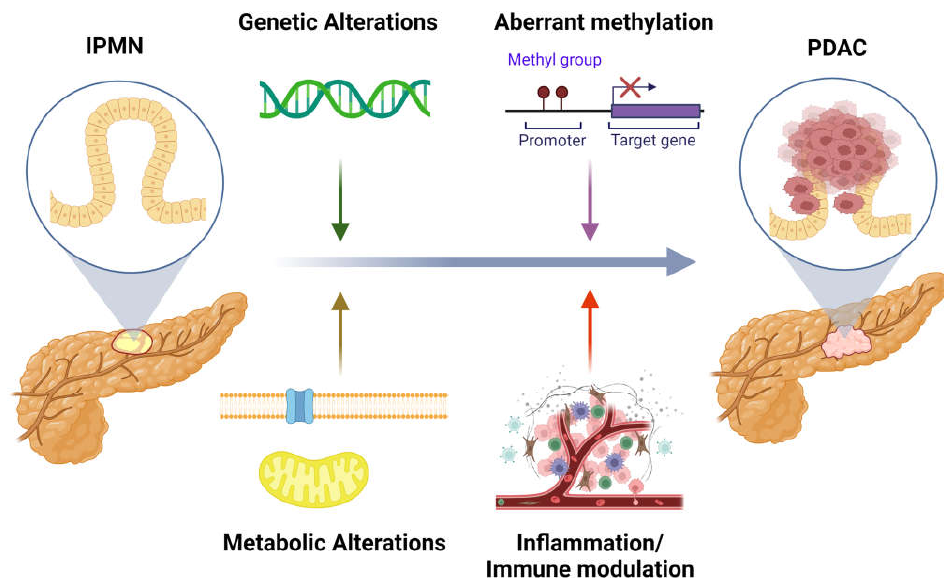
Figure 1. The impact of genetic, metabolic, inflammatory, and immunomodulatory mediators in progression of IPMN to PDAC. Created with BioRender.com.